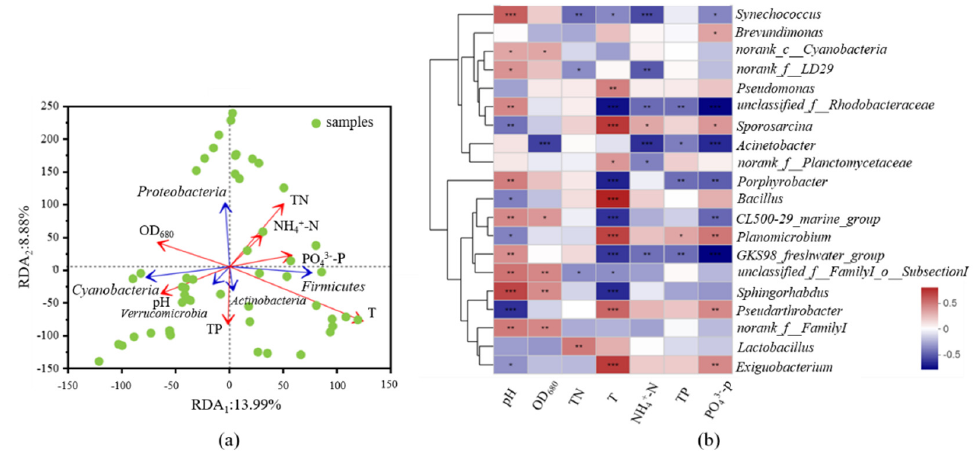
Figure 4. RDA analysis of environmental factors and the microbial community ( a ); Heatmap analysis of key environmental factors and microbial community with top 20 genera ( b ), * 0.01 < p ≤ 0.05, ** 0.001 < p ≤ 0.01, *** p ≤